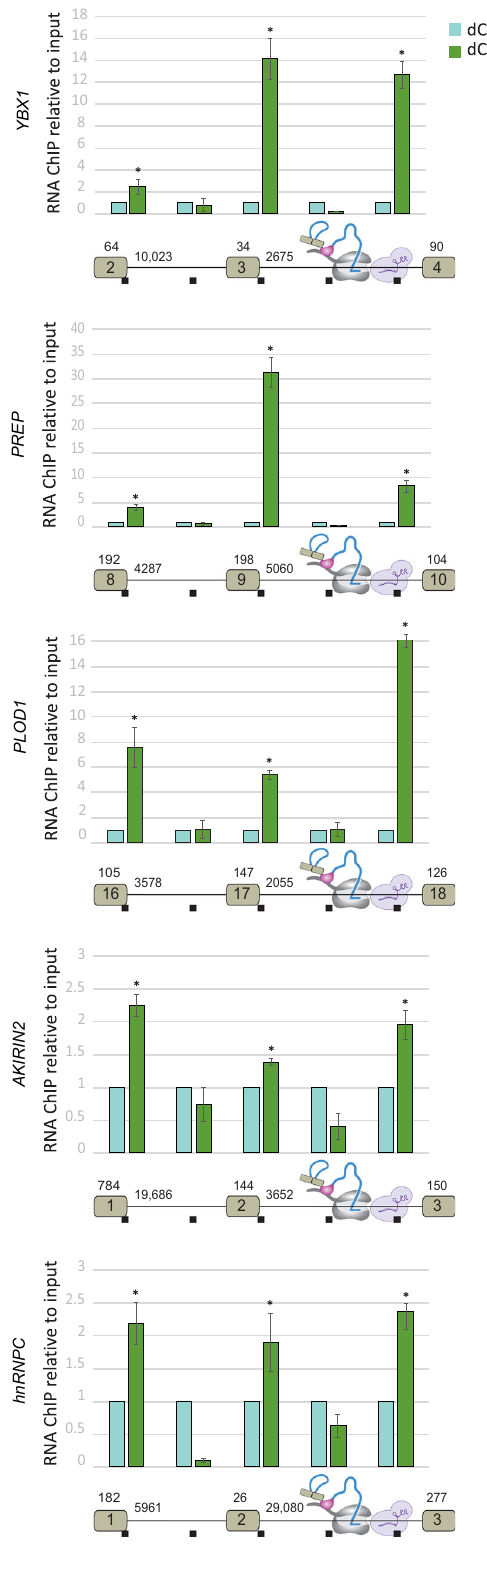
indicate that only the functional 5 ′ SS is associated with pol II. The 5 ′ SSs level in the WT cells was con fi rmed by quanti fi cation of the absolute amounts of each of the two exon – intron junctions in the pre-mRNA by qRT-PCR. The second 5 ′ SS level was higher compared to the fi rst 5 ′ SS (Supplementary Fig. 1g).